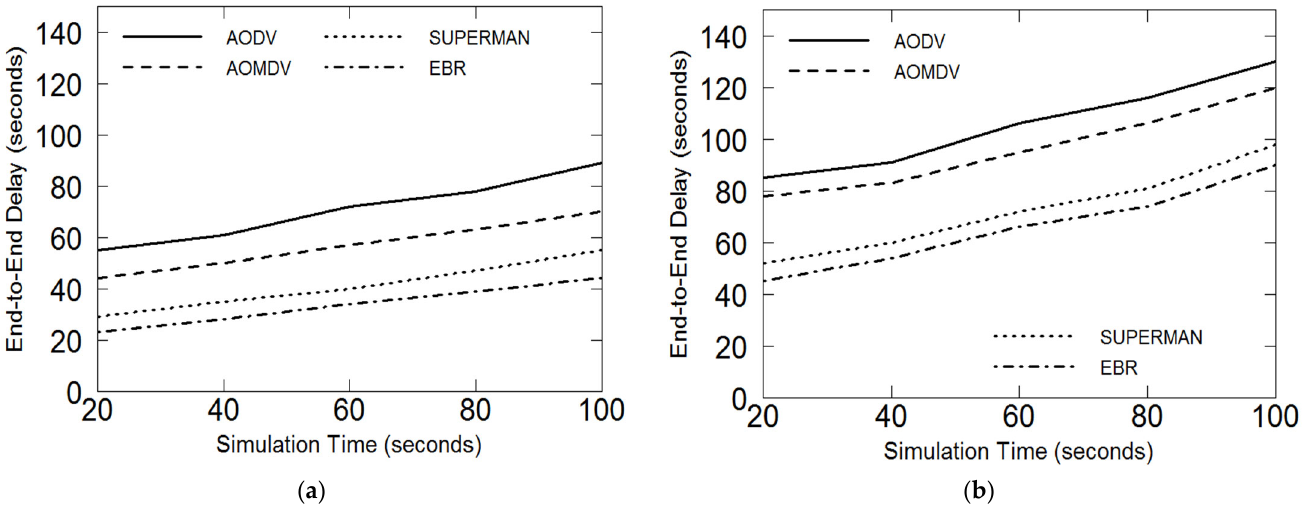
Figure 3. ( a ) End ‐ to ‐ end delay vs. simulation time (without attack); ( b ) End ‐ to ‐ end delay vs. sim ‐ Figure 3. ( a ) End-to-end delay vs. simulation time (without attack); ( b ) End-to-end delay vs. simula- ulation time (with attack). tion time (with